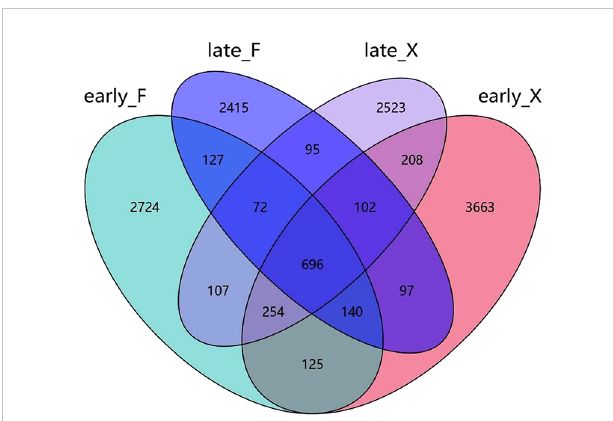
FIGURE 6 Venn diagram display of common or endemic species.